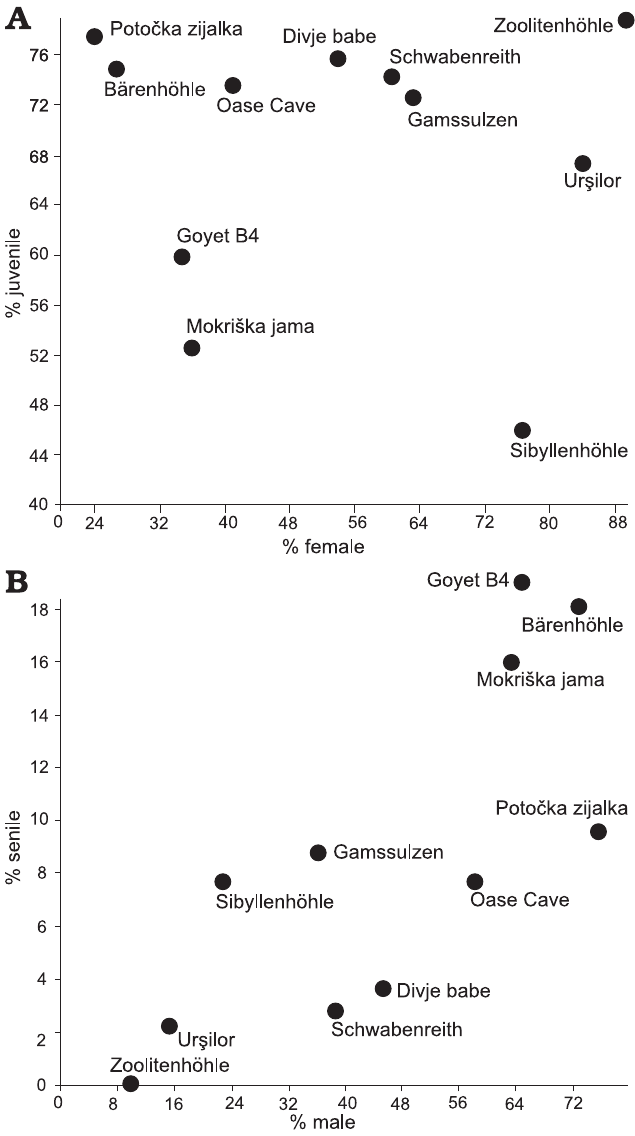
Fig. 6. Percentage of juveniles vs. females ( A ) and old individuals vs. males ( B ) of cave bears from Ur ş ilor, (~45–40 calendar kyrs BP). Data derived from SOM: tables 3 and